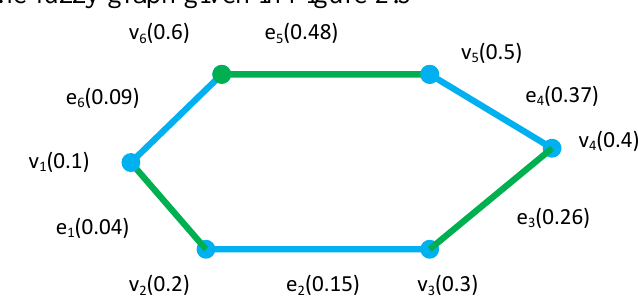
Figure 2.3: Fuzzy matching chromatic index of 𝐺